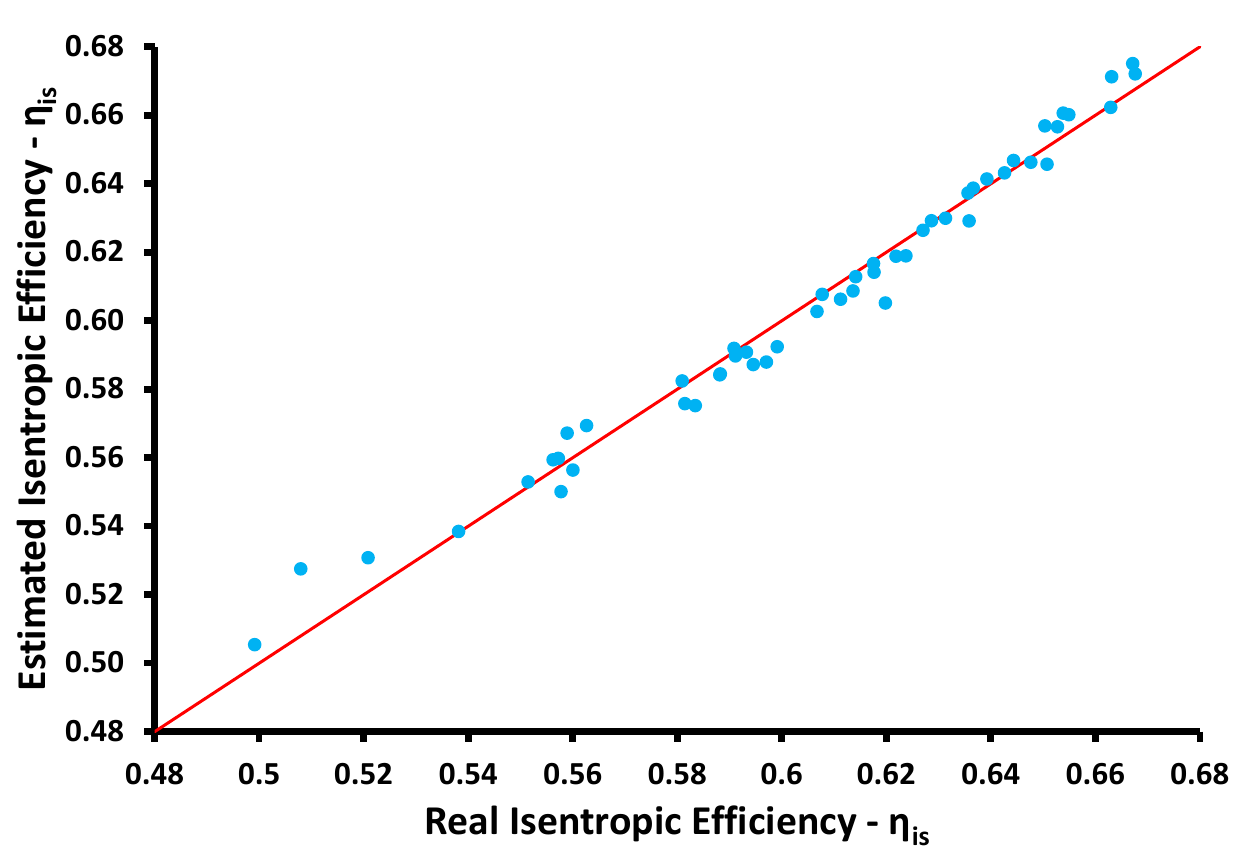
Figure 2. Comparison of the isentropic efficiency between the estimated value with the approxima- tion formula.